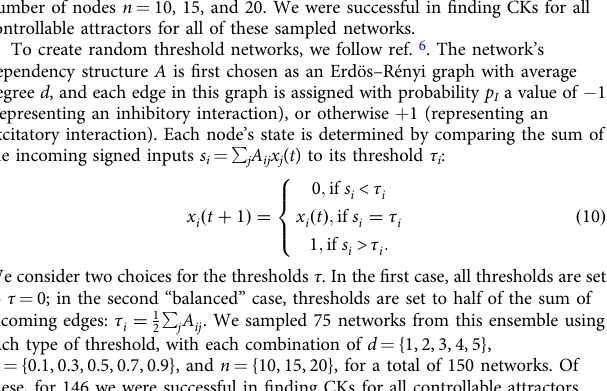
Table 1 The 49 analyzed biological regulatory